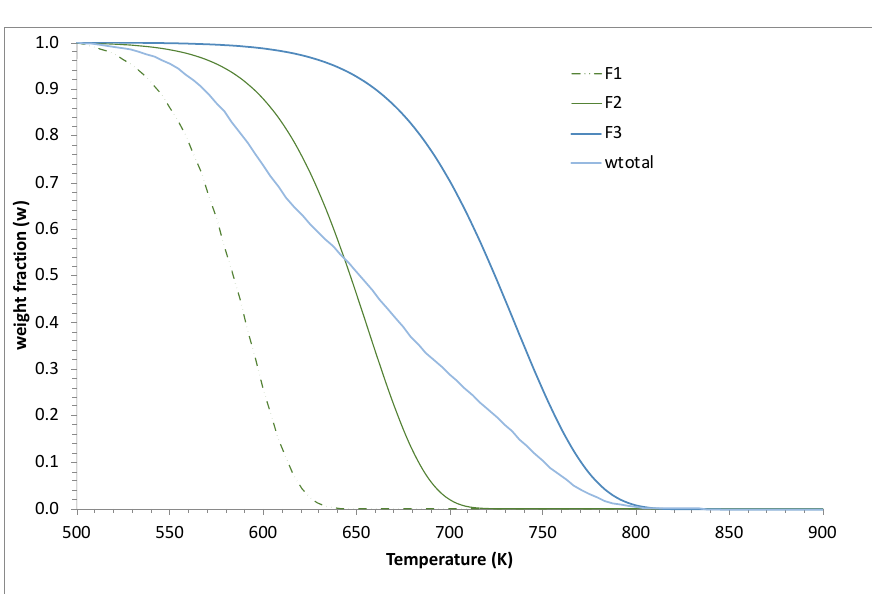
Figure 6. Evolution of the decomposition of three different initial organic fractions (F1, F2 and F3) and total weight loss (wtotal) for the simulation of a run performed at 10 K/min. The values of the kinetic parameters are shown in the main